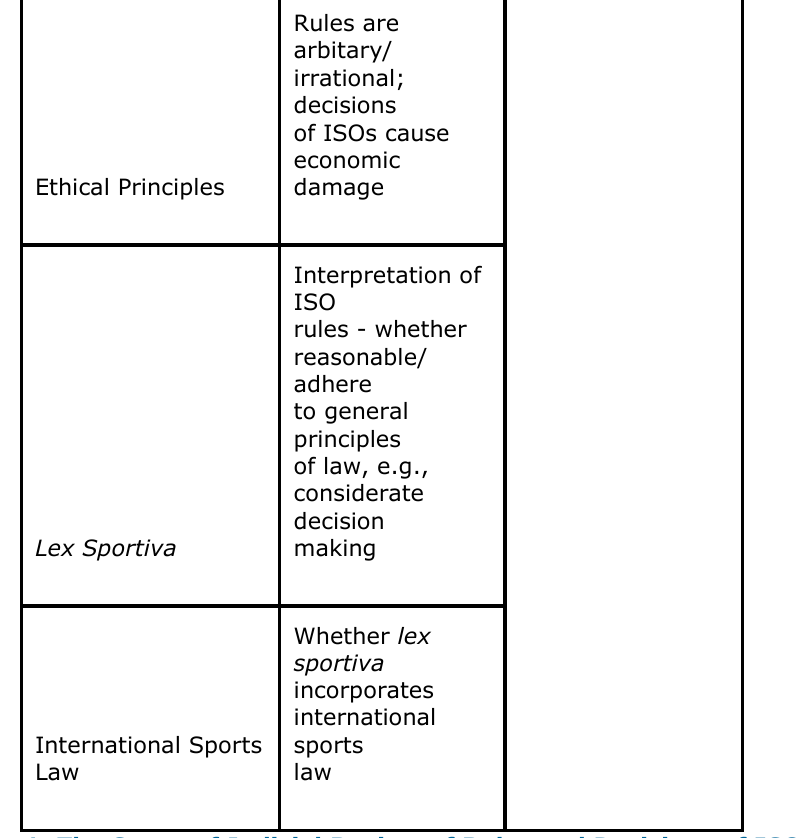
Table 1: The Scope of Judicial Review of Rules and Decisions of